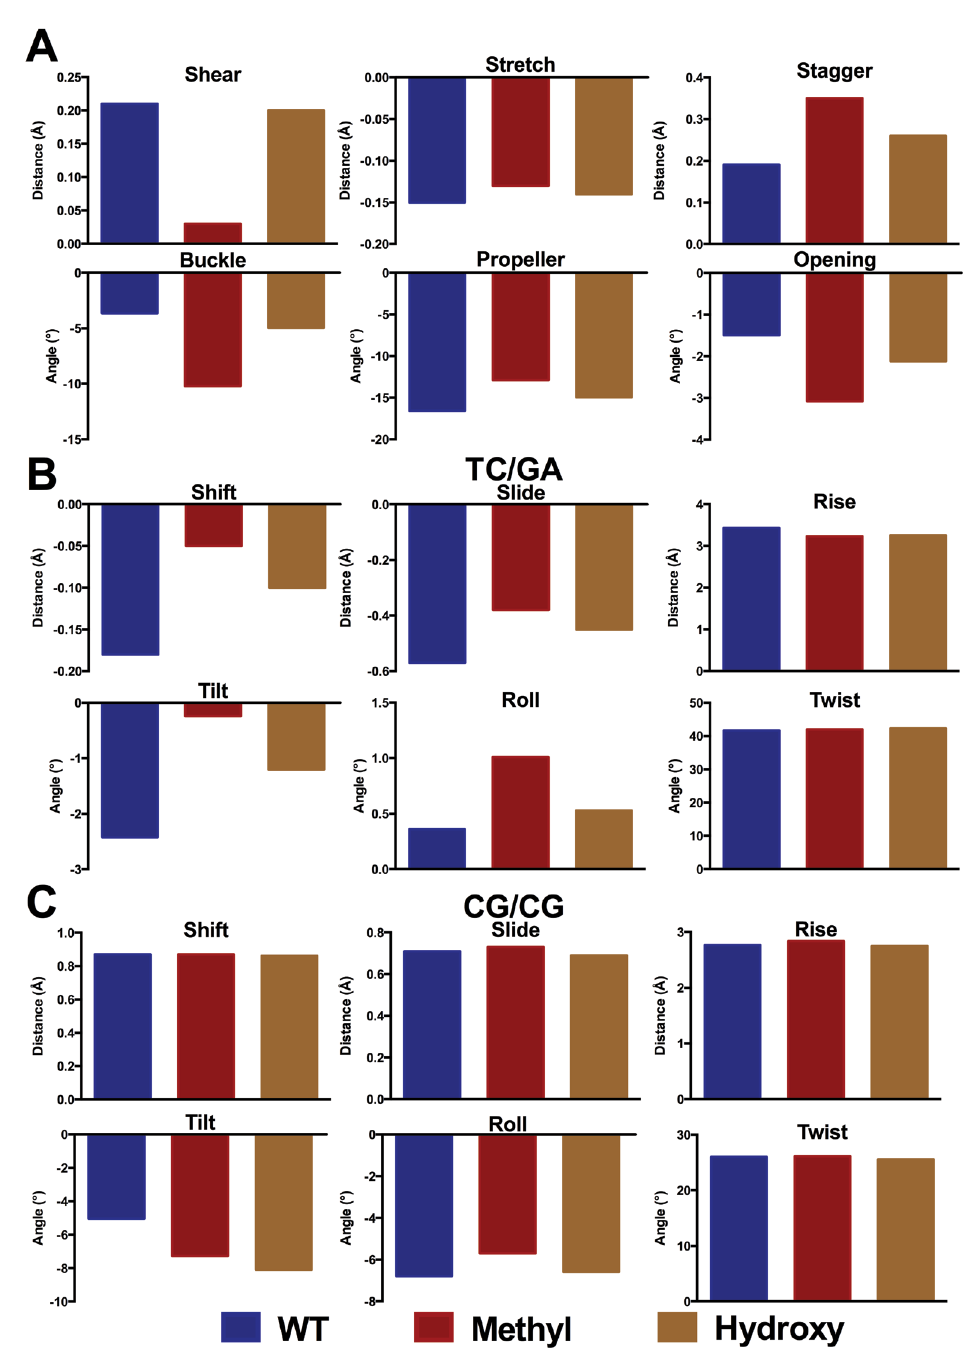
Figure 7. Base pair step parameters for central GC and modifications thereof in 5´-ATT CGCG-3´ (Å and °) taken from QM/MM optimisation. The corresponding values are shown in Data file